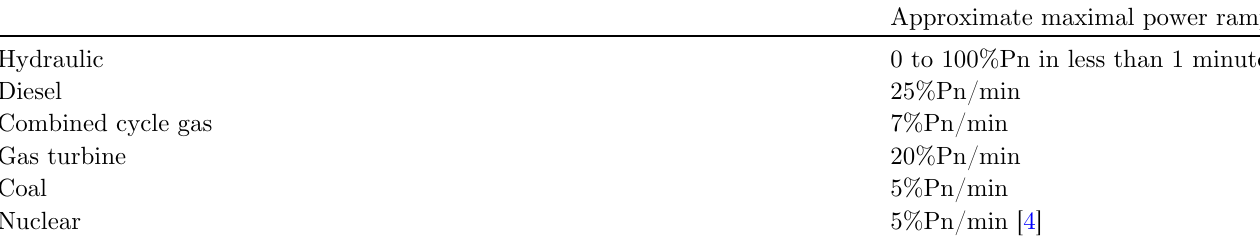
Table 2. Flexible capabilities of conventional plants